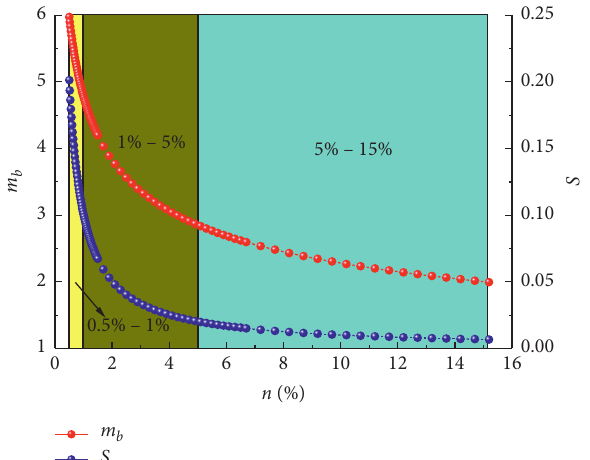
and R vary with the cm tm